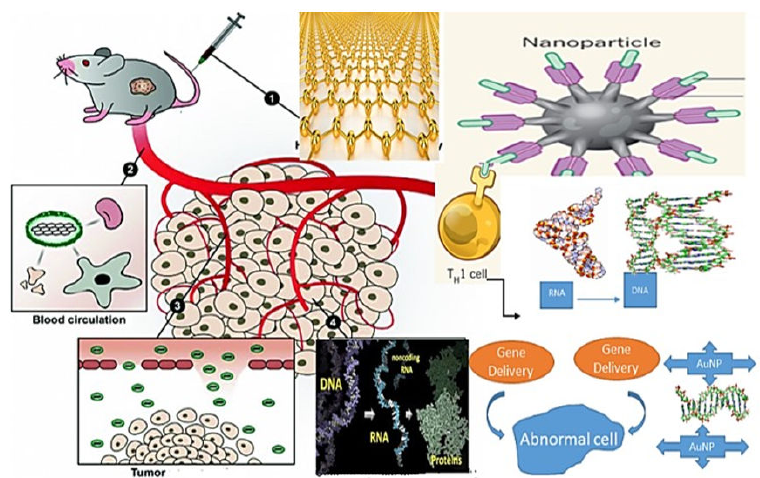
Figure 15. Schematic Gene Delivery of Gold Nanorods application.